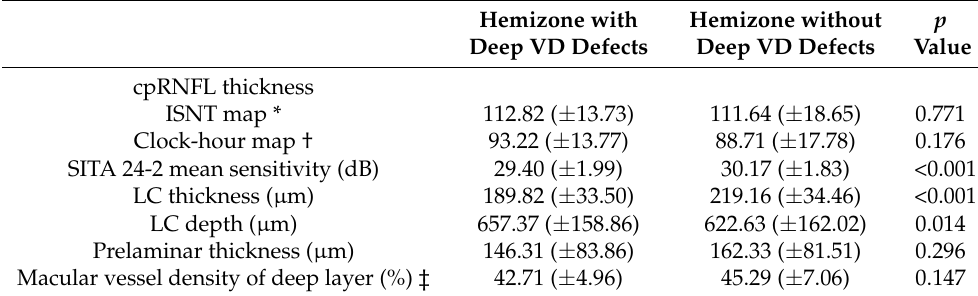
Table 3. Inter-hemizone comparisons in eyes with deep VD